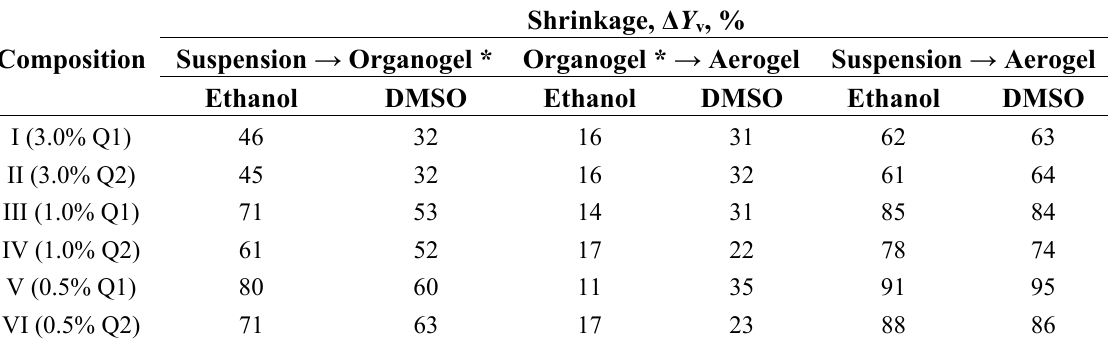
Table 2. Shrinkage during complete transformation from suspension to aerogel; solvent concentration gradient Δ C =